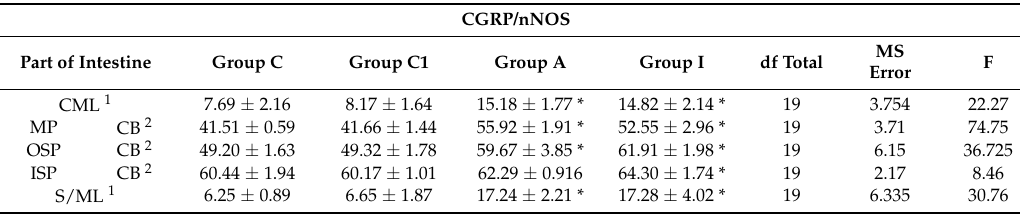
Table 5. Co-localization of CGRP with neuronal isoform of nitric oxide synthase (nNOS) in the enteric nervous structures of the porcine descending colon under physiological conditions (Group C), after “sham” operation (Group C1), after axotomy (Group A) and during inflammation (Group I). CGRP/nNOS MS Part of Intestine Group C Group C1 Group A Group I df Total F Error CML 1 7.69 ± 2.16 8.17 ± 1.64 15.18 ± 1.77 * 14.82 ± 2.14 * 22.27 MP 41.51 ± 0.59 41.66 ± 1.44 CB 2 60.44 ± 1.94 30.76 CML, circular muscle layer; MP, myenteric plexus; OSP, outer submucous plexus; ISP, inner submucous plexus; S/ML, submucosal/mucosal layer; CB, cell bodies; NF, nerve fibers. 1 Average number of nerve fibers per